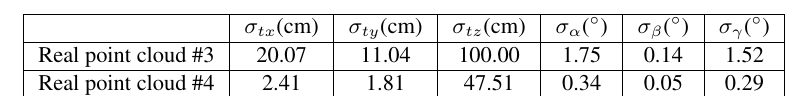
Table 16: Calibration of real point cloud #4